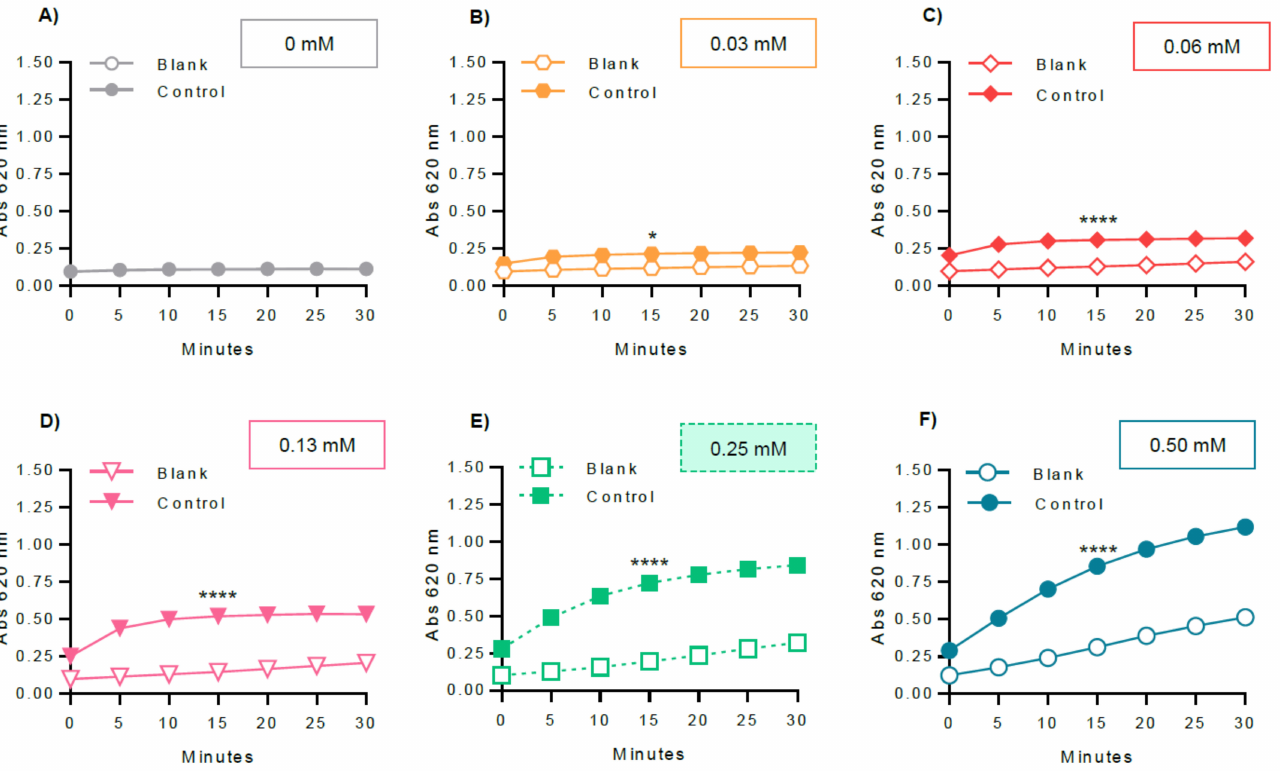
Figure 6. Optimization of the glucose 1-phosphate concentration: ( A ) 0 mM, ( B ) 0.03 mM, ( C ) 0.06 mM, ( D ) 0.13 mM, ( E ) 0.25 mM, and ( F ) 0.50 mM. GPa, glycogen, and temperature were fixed at 0.38 U/mL, 1.00 mg/mL, and 37 ◦ C, respectively. The blank contained the same constituents as the control, except the enzyme. The obtained results represent at least four independent experiments and were graphically represented as mean ± SEM. * p < 0.05; **** p < 0.0001 when compared with the blank (without enzyme) at 15 min of